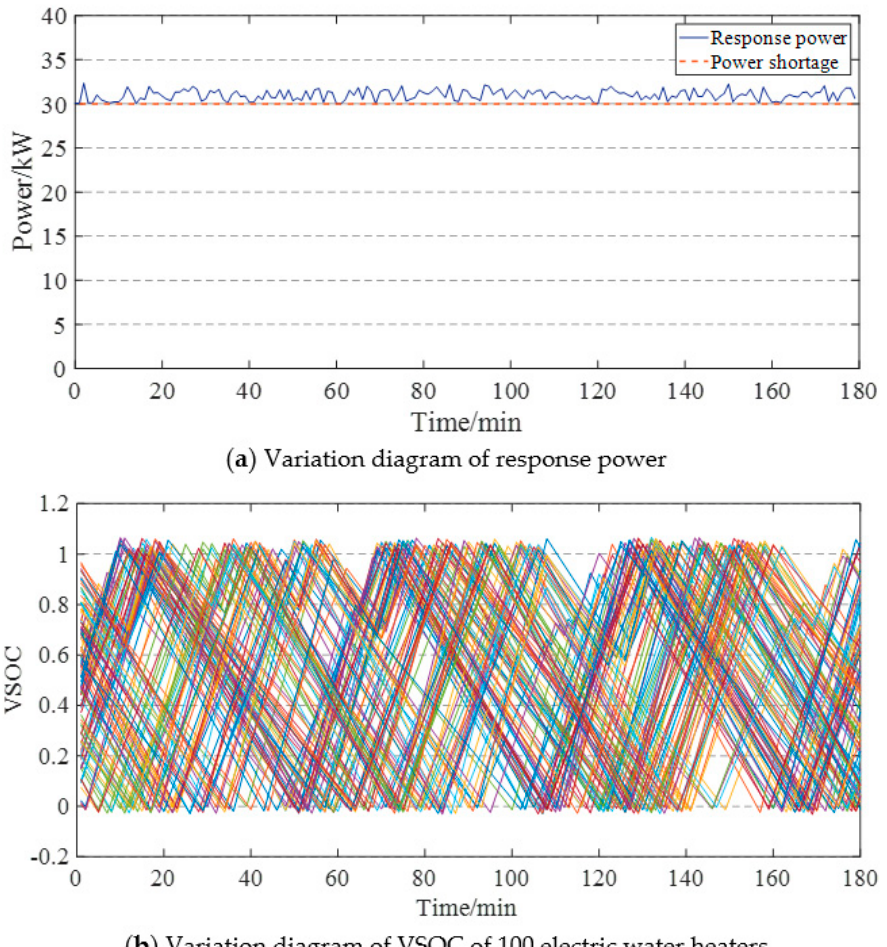
Figure 14. Control effect of optimized control strategy for electric water heaters.